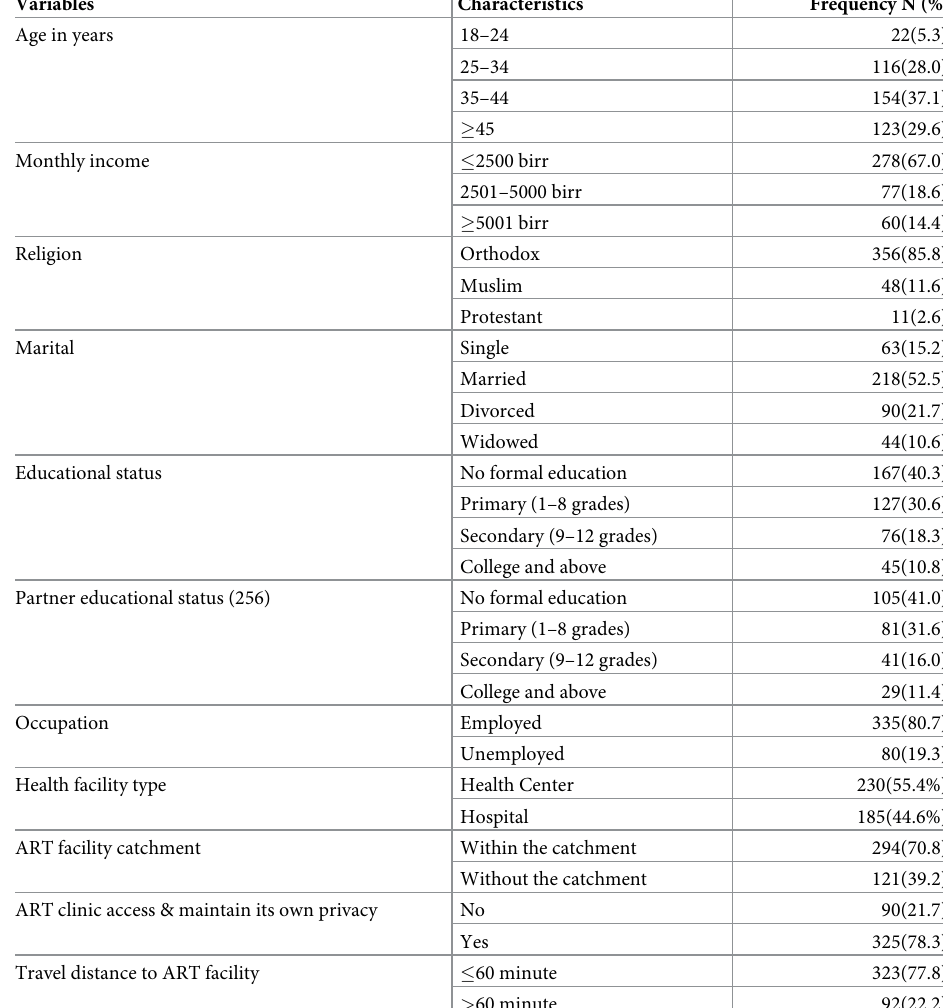
Table 1. Socio-demographic, economic, and service delivery-related factors of uptake ASM among stable clients on antiretroviral therapy in East Gojjam Zone, Amhara, Northwest Ethiopia, 2020 (n =